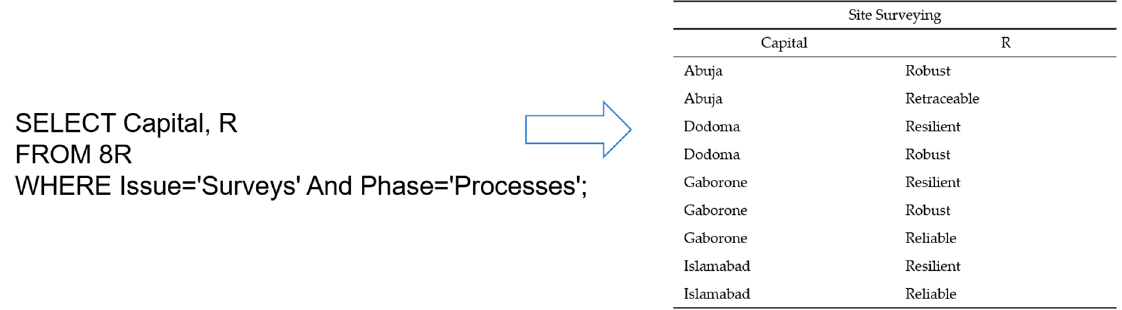
Figure 1. Access database: simple SQL codes filter the database for cases where the examined issue has occurred and outputs the connected capital and “R”; here, the database is searched for capital relocations that underwent extensive site surveying before the resettlement.